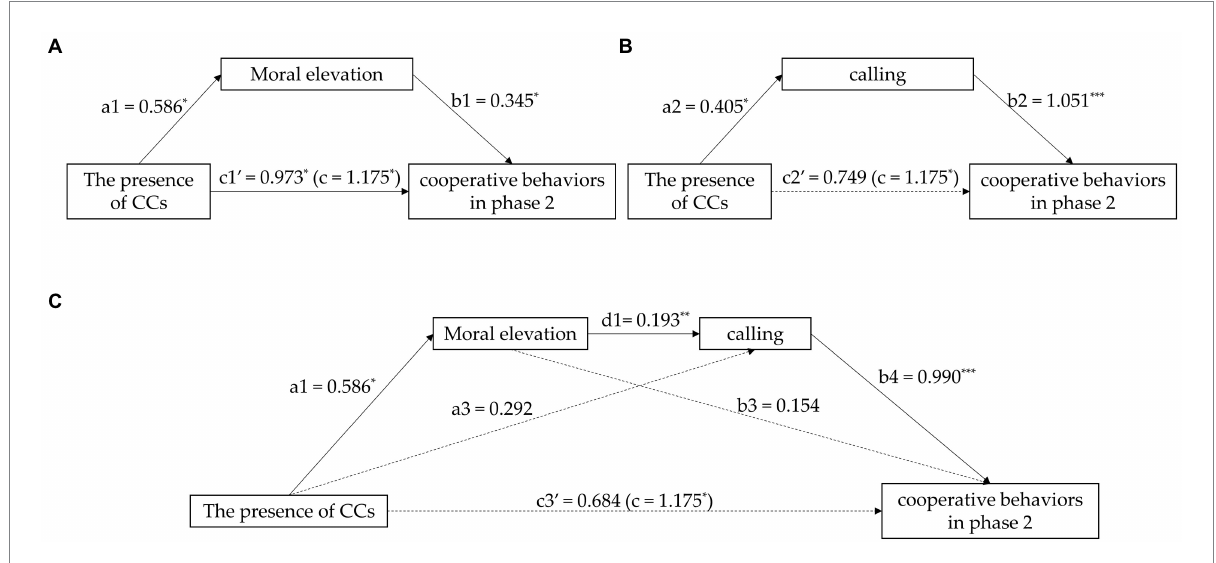
FIGURE 3 (A) The mediation effect of moral elevation in the relationship between the presence of CCs and cooperative behaviors in the second phase; (B) The mediation effect of calling in the relationship between the presence of CCs and cooperative behaviors in the second phase; (C) The chain- mediation effect of moral elevation and calling in the relationship between the presence of CCs and cooperative behaviors in the second phase. The path coefficients are unstandardized. Path coefficients with solid lines are significant; path coefficients with dashed lines are not significant; * p < 0.05, ** p < 0.01, *** p <